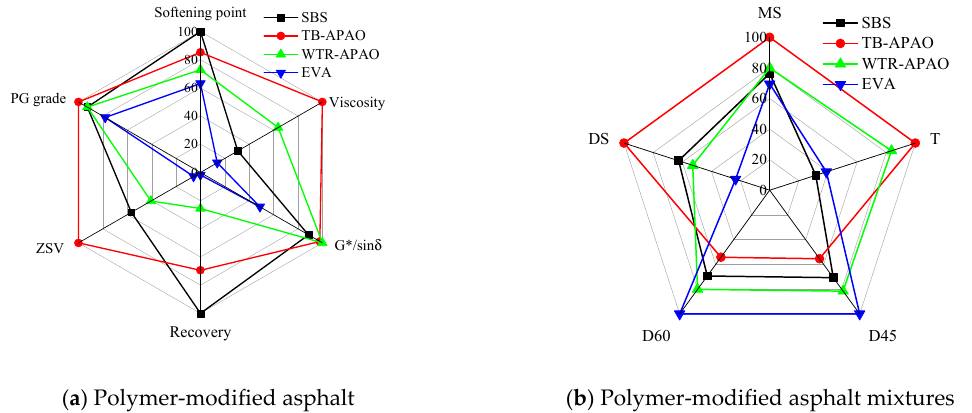
Figure 4 represented the normalized technical indexes of the asphalt and asphalt mixtures.